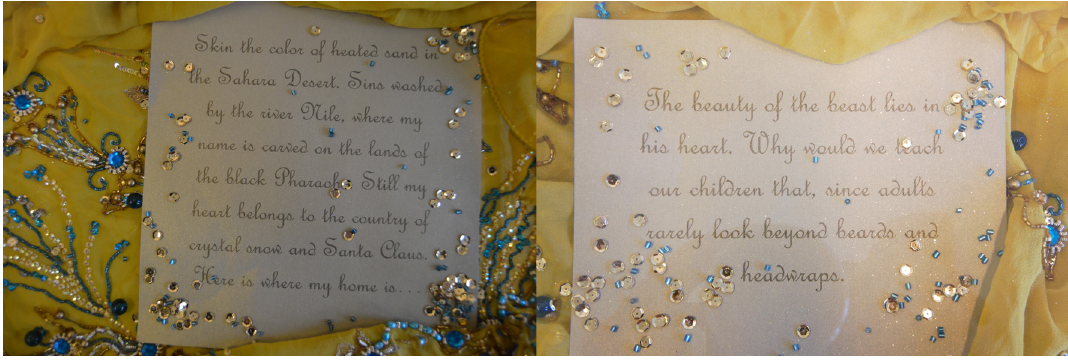
Figure 3. Two poems from the installation. The second says: The beauty of the beast lies in his heart. Why would we teach our children that since adults rarely look beyond beards and